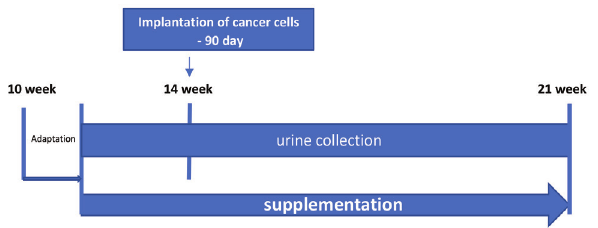
Figure 1: Scheme of the experimental